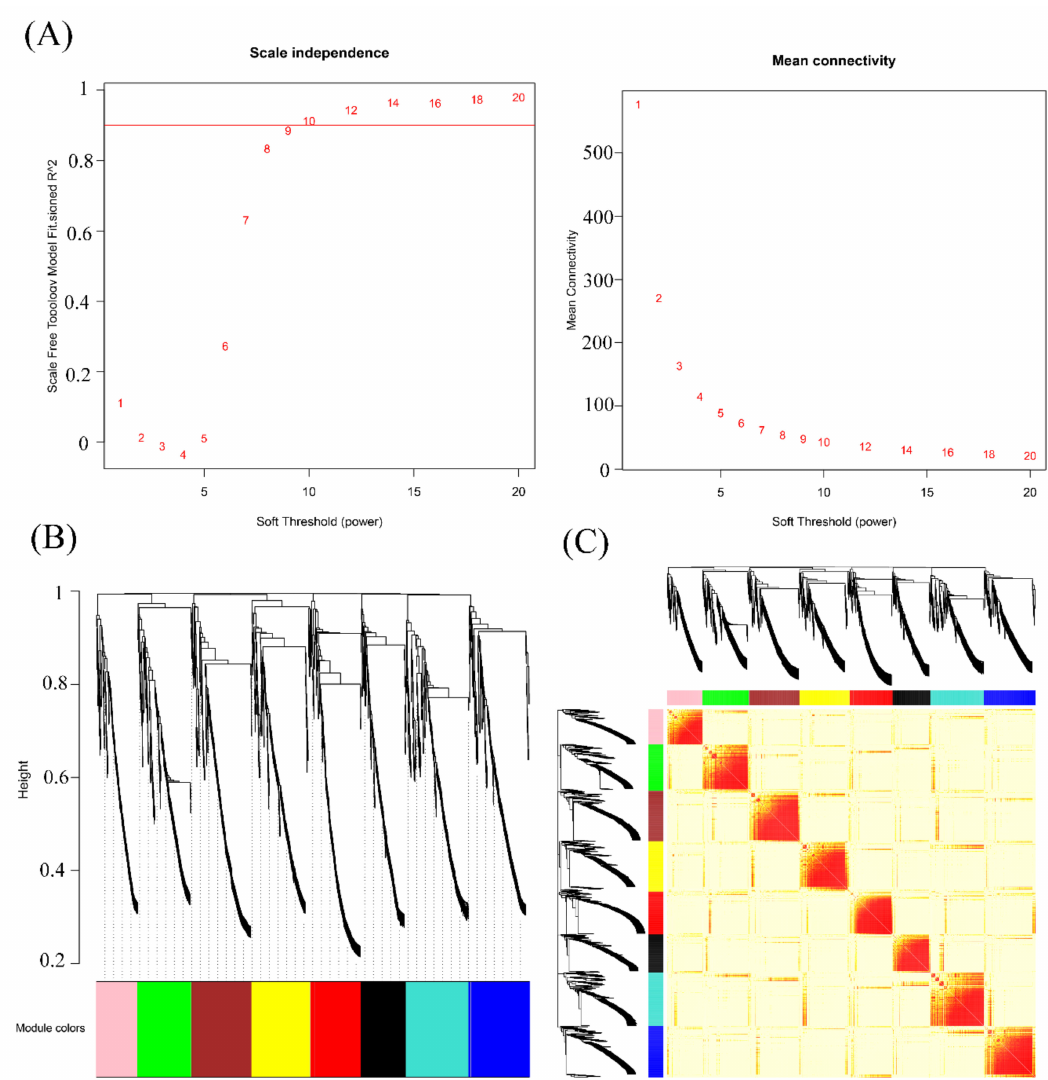
Figure 2. Module identification by WGCNA. ( A ) Selection of the soft threshold with scale independence and mean connectivity. ( B ) Cluster dendrogram of the eight modules. The expression patterns of genes in the gray module are not significantly related, and the genes were not classified into any module. ( C ) Heatmap of the eight